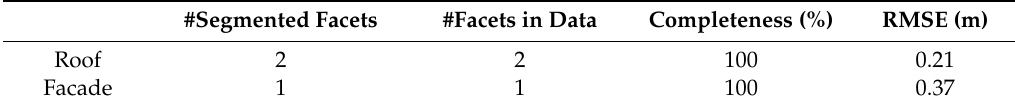
Table 9. Completeness and accuracy of roof and façade segmentation.